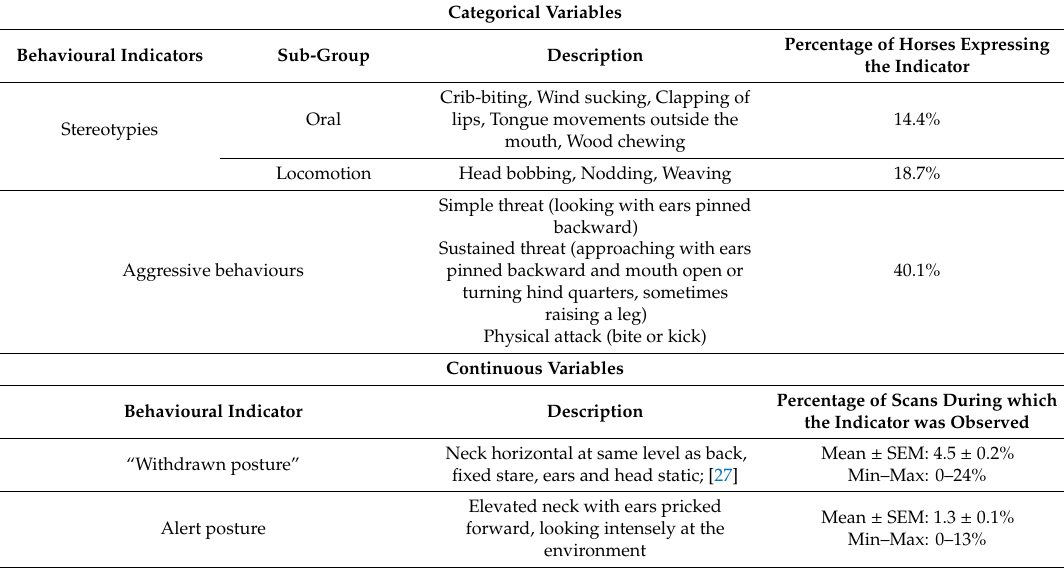
Table 2. Description of the behavioural indicators of the compromised welfare state in the sample. Stereotypies were divided into two sub-groups (oral and locomotion) because they could be influenced by di ff erent environmental factors. Descriptive statistics are presented as the percentage of horses expressing stereotypies and aggressive behaviours and the percentage of scans during which the “withdrawn” and alert postures were observed (mean ± SEM,